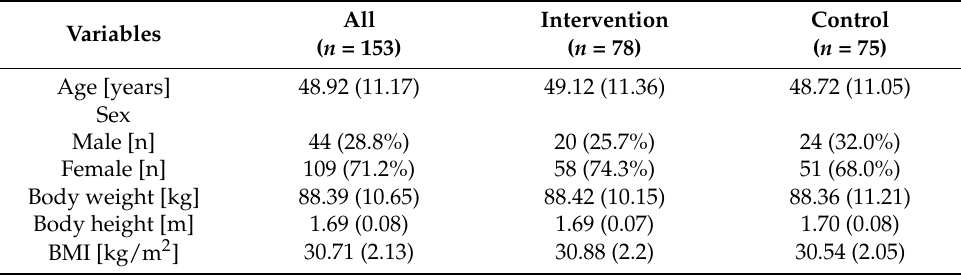
Table 1. Baseline (t0) characteristics of the study participants 1